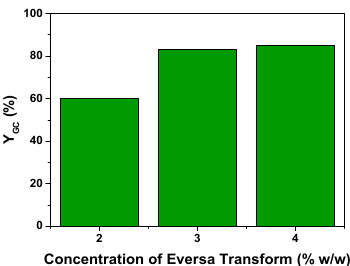
Figure 8. Effect of the amount of the Eversa Transform enzymatic preparation used in the transesterification of Gly with EC on the yield to GC. Conditions: T = 60 °C ; EC:Gly = 3:1; solvent: tert-butanol (30% v / v ); t = 100 h; agitation speed: 400 rpm.